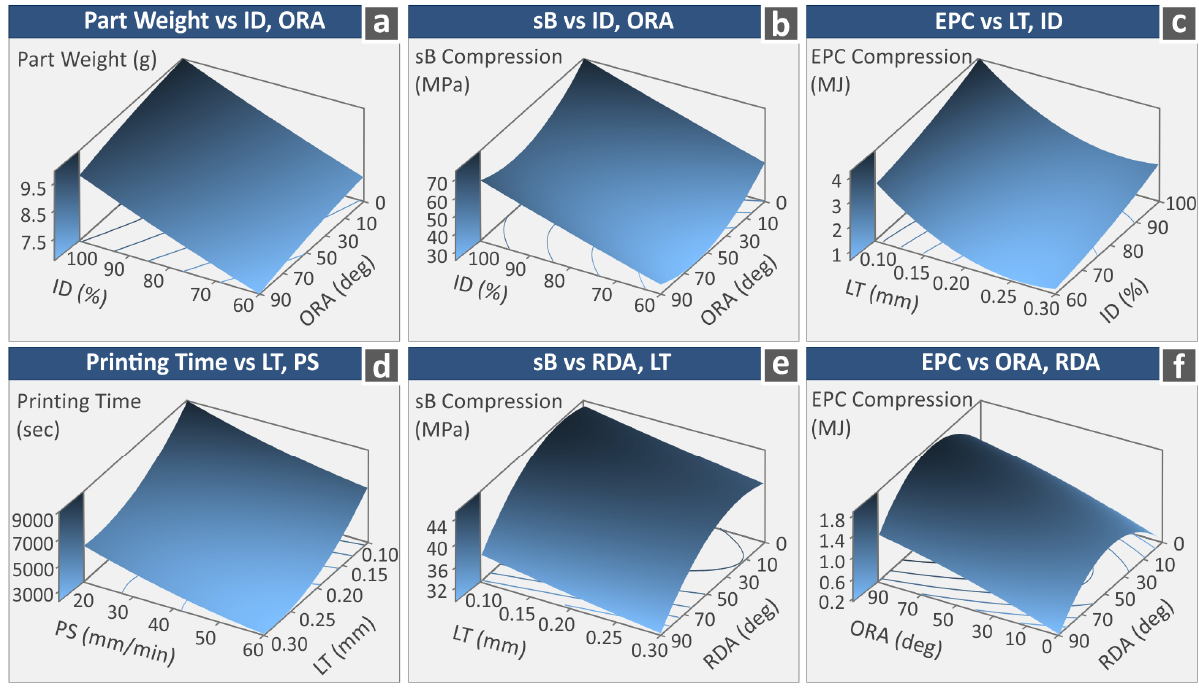
Figure 12. Pareto chart for ( a ) compressive strength (MPa) and the ( b ) energy (MJ). The statistically significant parameters are those crossing the threshold value of 1.98. On the right side, the experi- mental vs. the predicted values are presented.